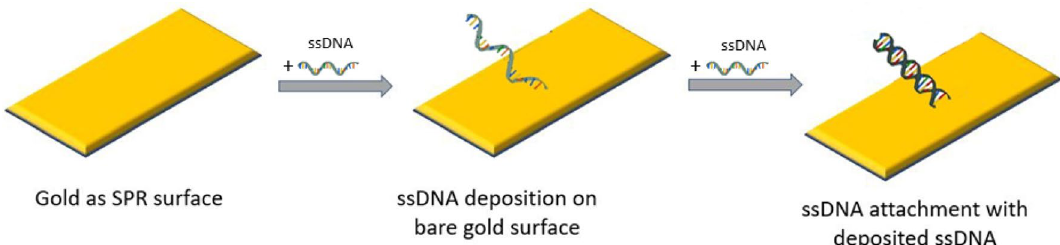
Figure 1. A schematic diagram of DNA attachment on gold surface of